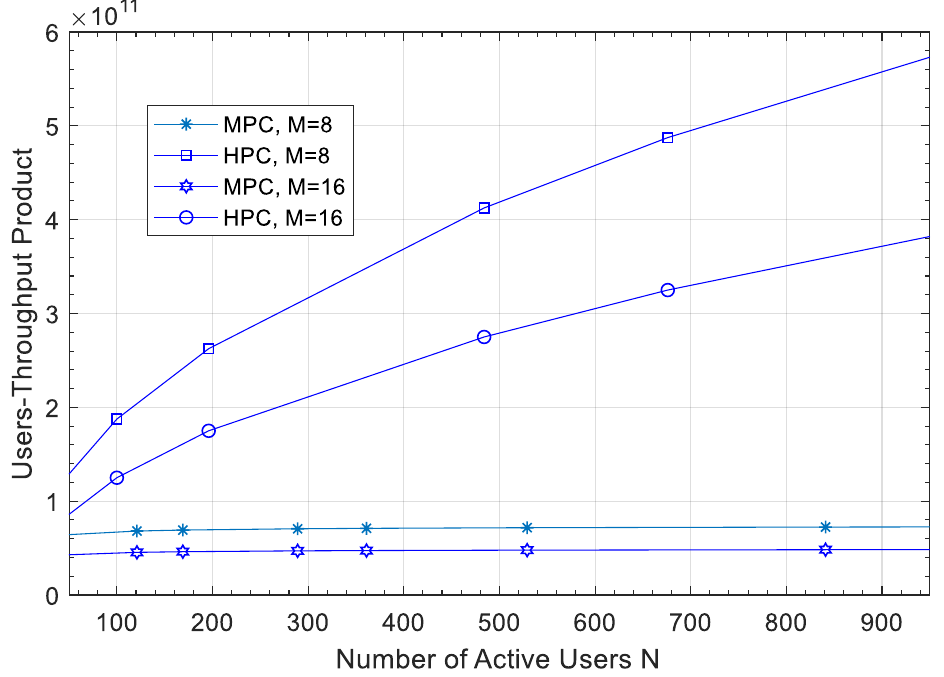
Figure 23. User throughput product versus the number of active users N.